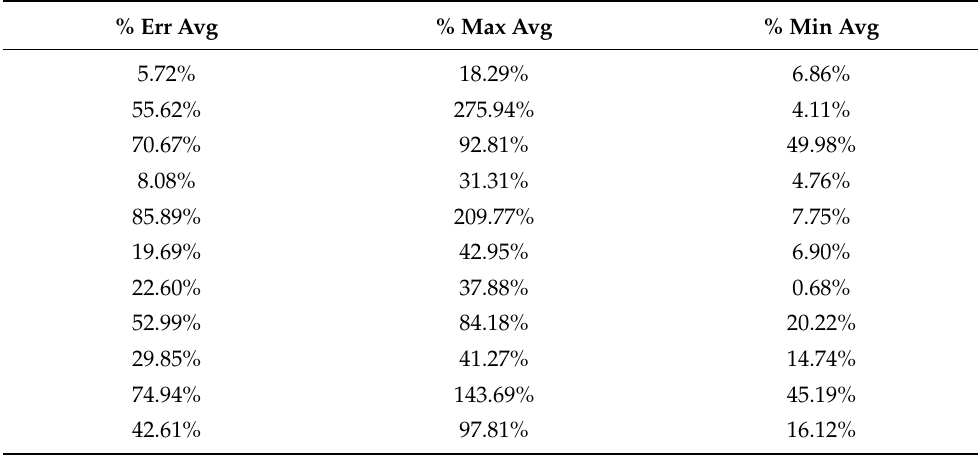
Table A166. Set 3, trials 1–10 data (actual PR value).